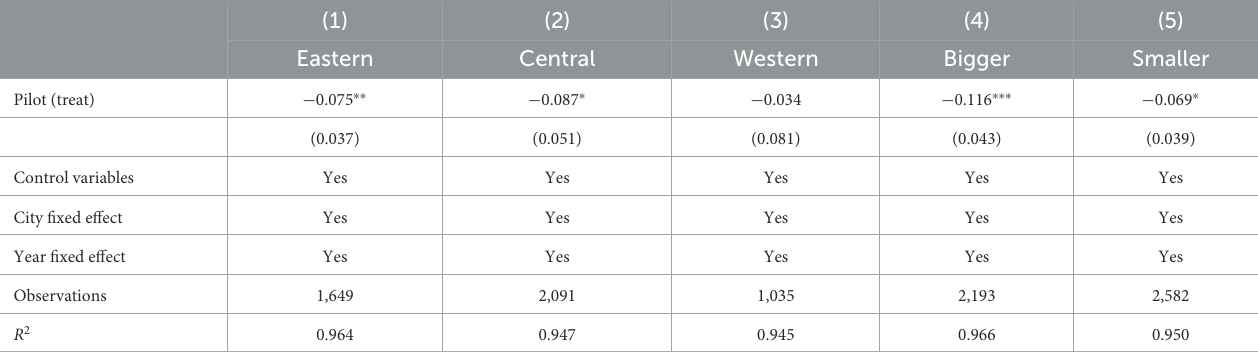
TABLE 6 Heterogeneity analysis of